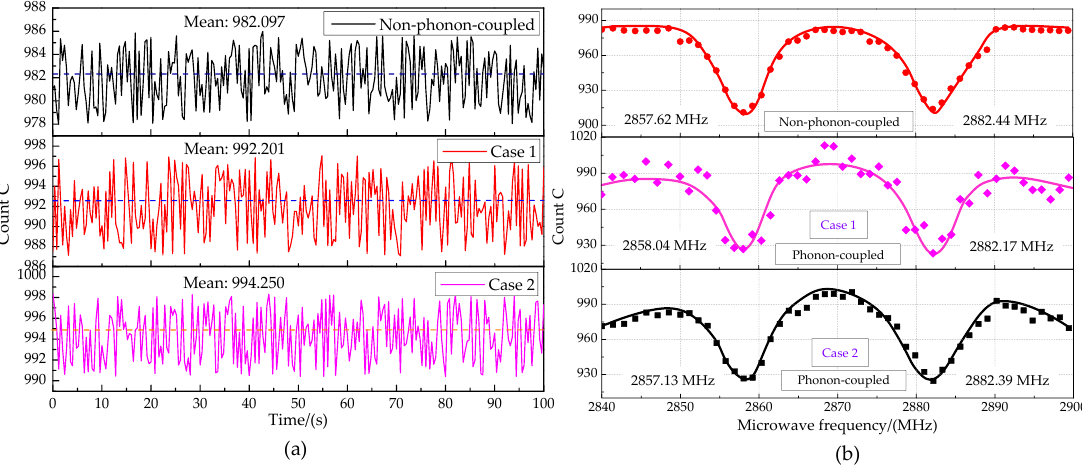
Figure 24. ( a ) Time-domain measurement at the MW frequency of 2870 MHz ( b ) ODMR spectrum. The Rabi measurement results for the phonon-coupled case and the non-phonon- coupled case are shown in Figure 25. The π pulse time of the single NV center for the phonon-coupled case is 148.04256 ns, and that for the non-phonon-coupled case is 148.998 ns. The Rabi oscillation amplitude increased by 1.14% for the